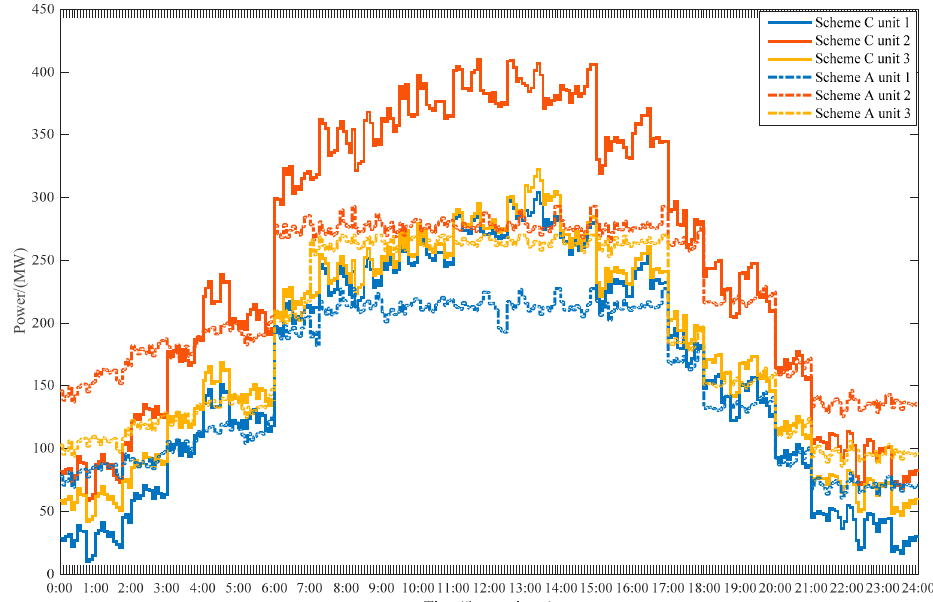
Figure 11. Thermal generator power outputs after applying real-time scheduling of schemes A and C. Table 2. Power generation operating costs of schemes A and C.